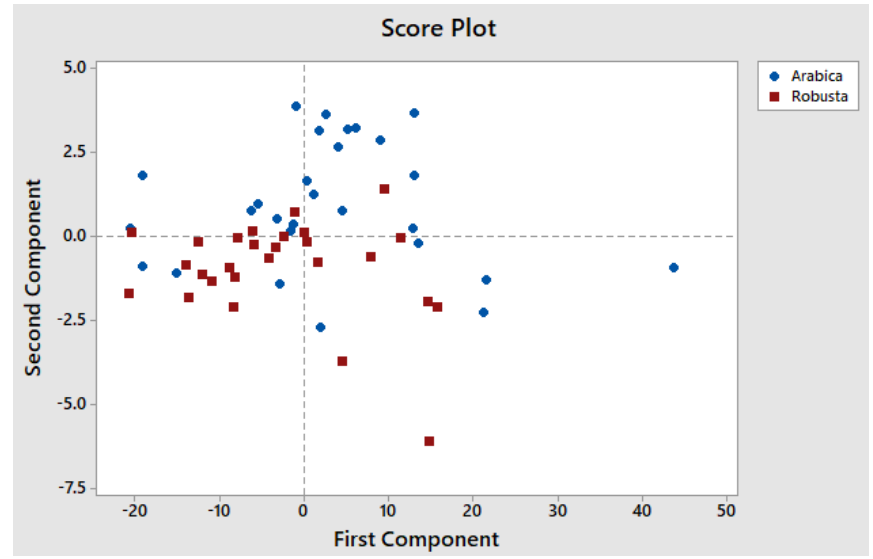
Figure 8. PCA score plot of Arabica and Robusta coffee beans.